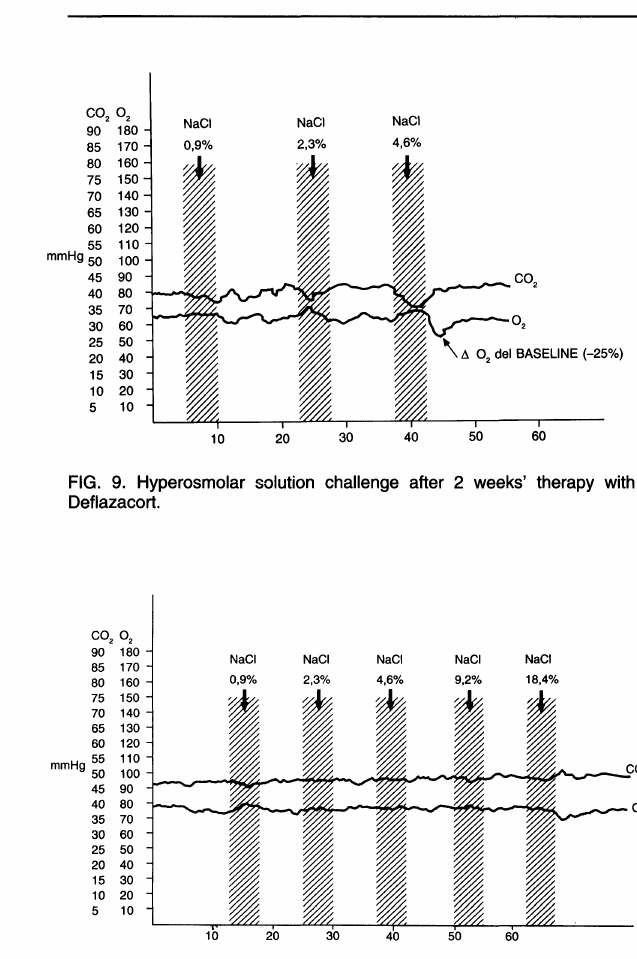
FIG. 10. Hyperosmolar solution challenge after 4 months’ theapy with NED +